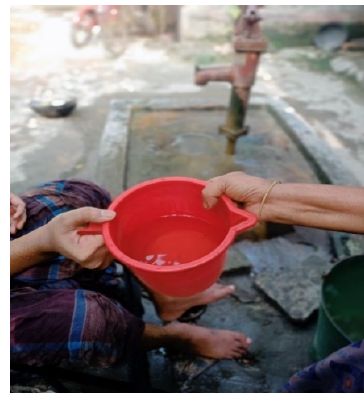
Figure 13. Alt-text: A red jug of water being passed from a mother’s hand to her son’s hand.